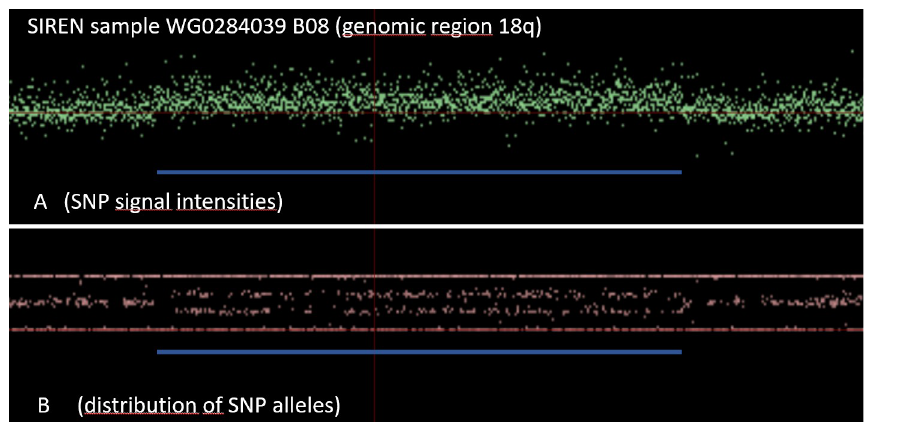
Fig 6. Zoom-in of the SIREN case with a CNV duplication in